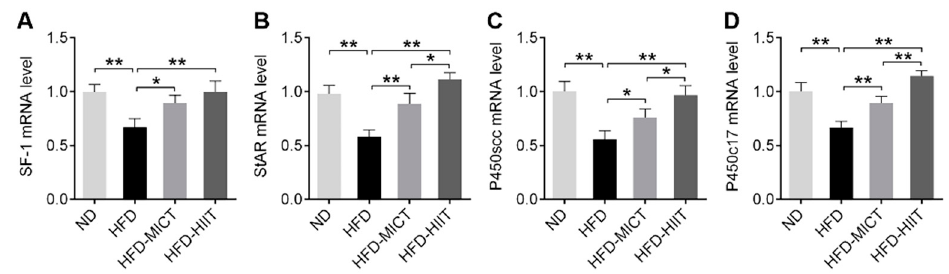
Figure 4. Effects of MICT and HIIT on mRNA expression of steroidogenic enzymes in the testes of obese mice. The gene expression of ( A ) SF-1, ( B ) StAR, ( C ) P450scc and ( D ) P450c17 in mouse testes were detected by RT-PCR. Data are expressed as mean ± SEM. * p < 0.05, ** p < 0.01.